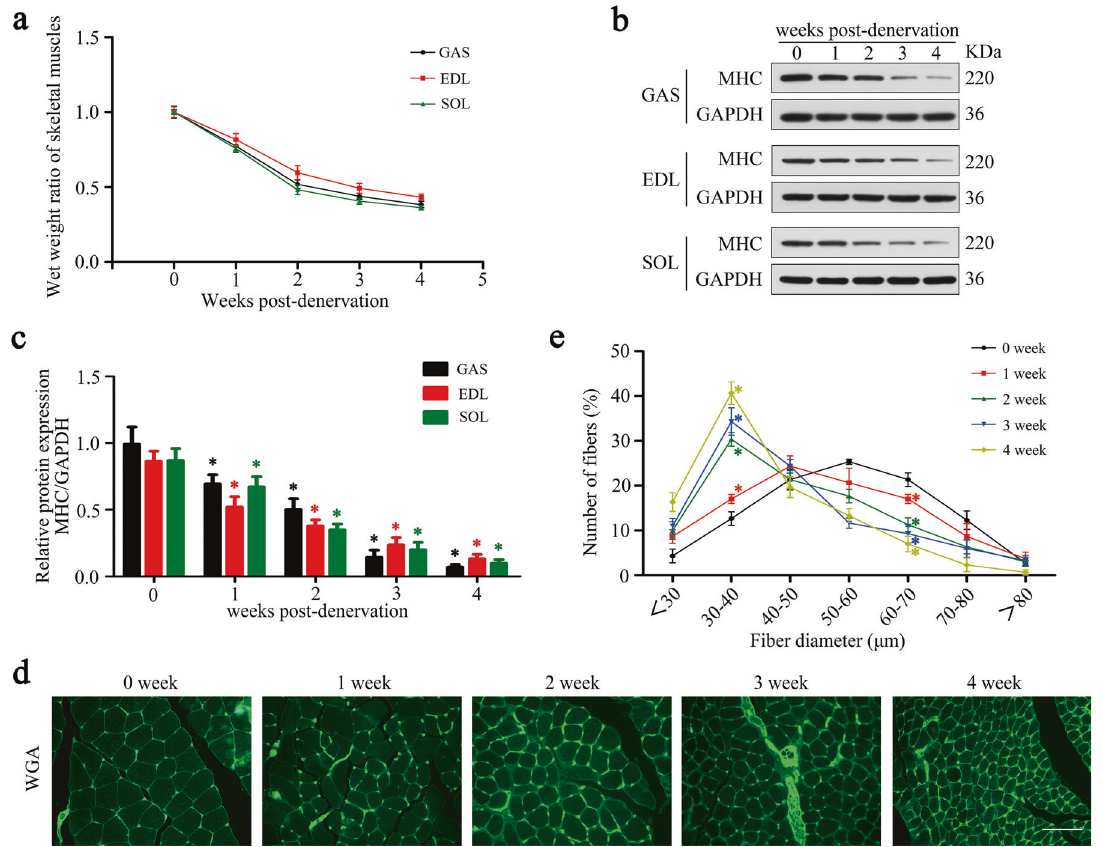
Fig. 1 Denervation led to atrophy of the dominated muscles. a The wet-weight ratio (the weight of the operational side divided by the contralateral side) of GAS, EDL, and SOL at the indicated time points post denervation. b, c Western blot analysis of the dynamic changes of MHC protein expression after denervation. d, e Quanti fi cation of gastrocnemius fi ber diameter by immuno fl uorescence staining of WGA. Scale bar 50 μ m. Data were presented as mean ± SD. n = 6. * P < 0.05 vs control (zero